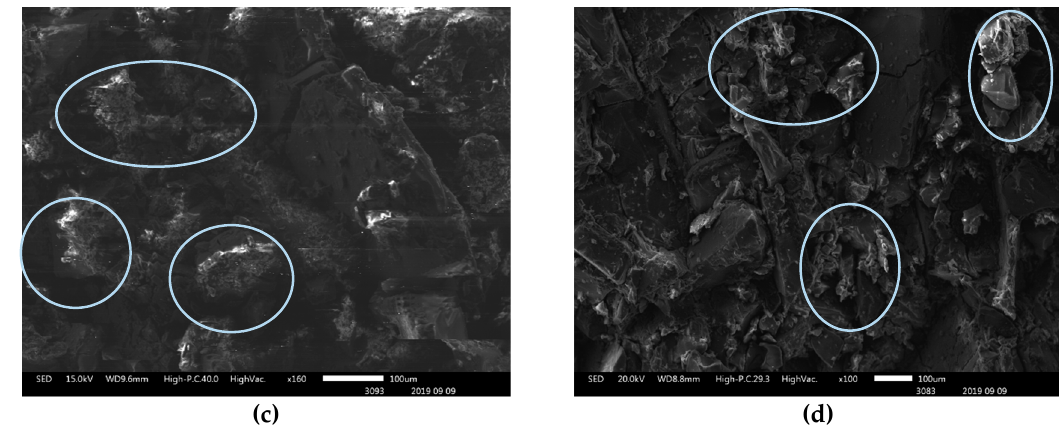
Figure 5. SEM images of ( a ) PMMI, ( b ) PMMI-Li + , ( c ) PMMI / FGO and ( d ) PMMI-Li + / FGO. Circled zones show filler aggregates.